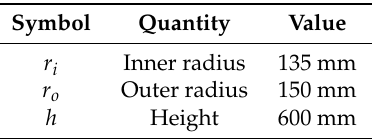
Figure 3. Polar and transversal moment of inertia ratio of the flywheel versus inner and outer radius ratio ( a ). Flywheel height versus inner and outer radius ratio ( b ). Table 2. Dimensions of the